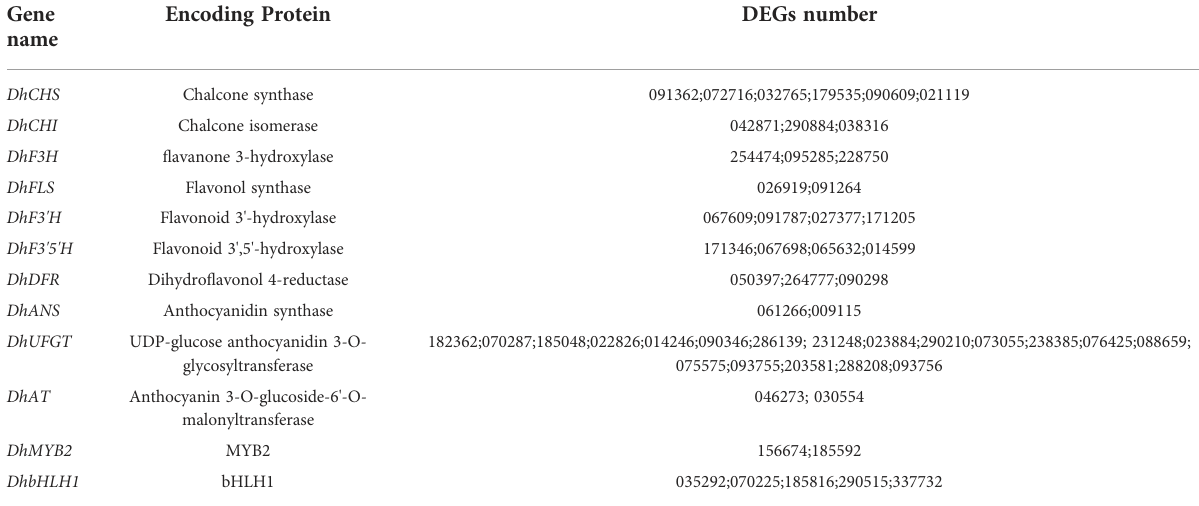
TABLE 2 Differentially expressed genes (DEGs) information related to anthocyanin biosynthesis